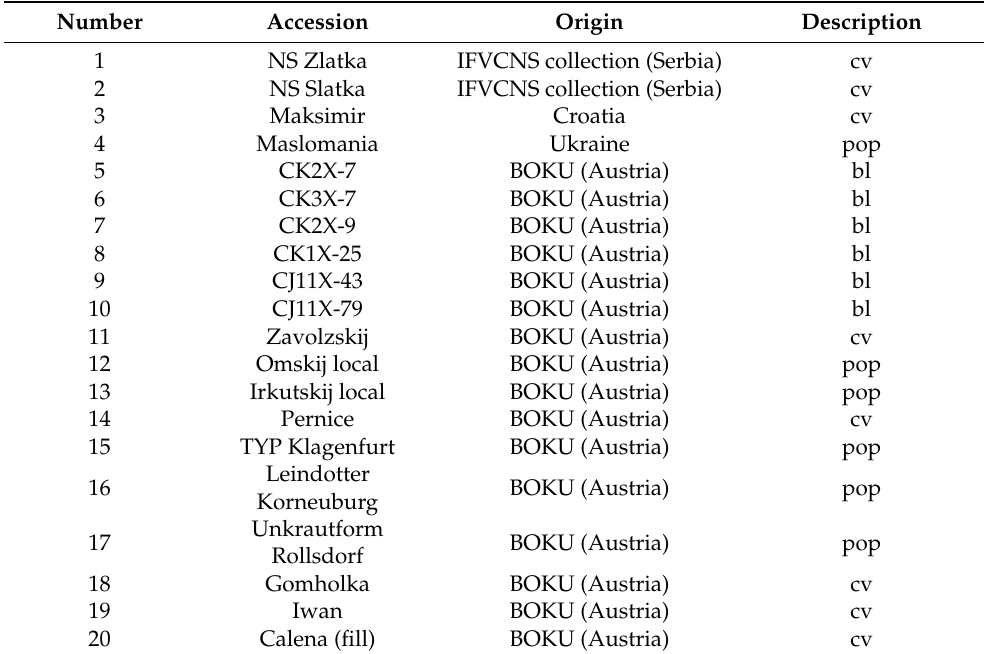
Table 1. Description of camelina accessions used in the study.